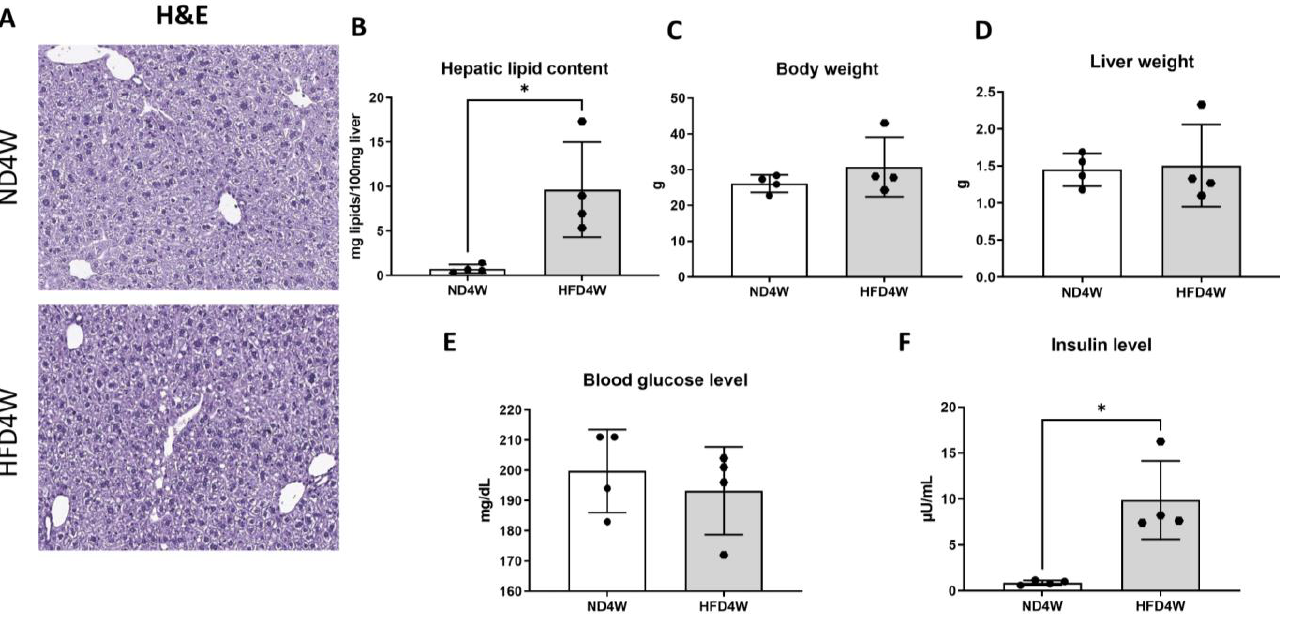
Figure 1. Foz − / − mice develop steatohepatitis, obesity, and insulin resistance. Liver haematoxylin and eosin staining (H&E) ( A ), hepatic lipid content ( B ), body weight ( C ), liver weight ( D ), blood glucose level ( E ), and insulin level ( F ) in mice fed a normal diet (ND4W) or a high fat diet for 4 weeks (HFD4W). Liver haematoxylin and eosin staining (H&E) ( G ), hepatic lipid content ( H ), body weight ( I ), liver weight ( J ), blood glucose level ( K ), and insulin level ( L ) in mice fed a normal diet (ND12W) or a high fat diet for 12 (HFD12W) or 30 weeks (HFD30W). n = 4 – 12/group. * p < 0.05, ** p < 0.01, *** p < 0.001, **** p < 0.0001.